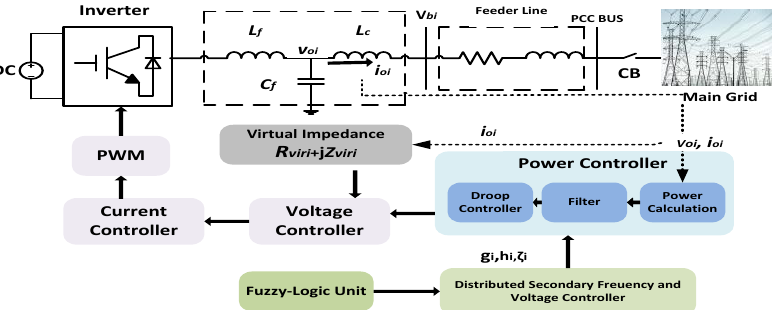
Figure 1. Simplified block diagram for the distributed generation (DG) unit with primary and secondary controllers.